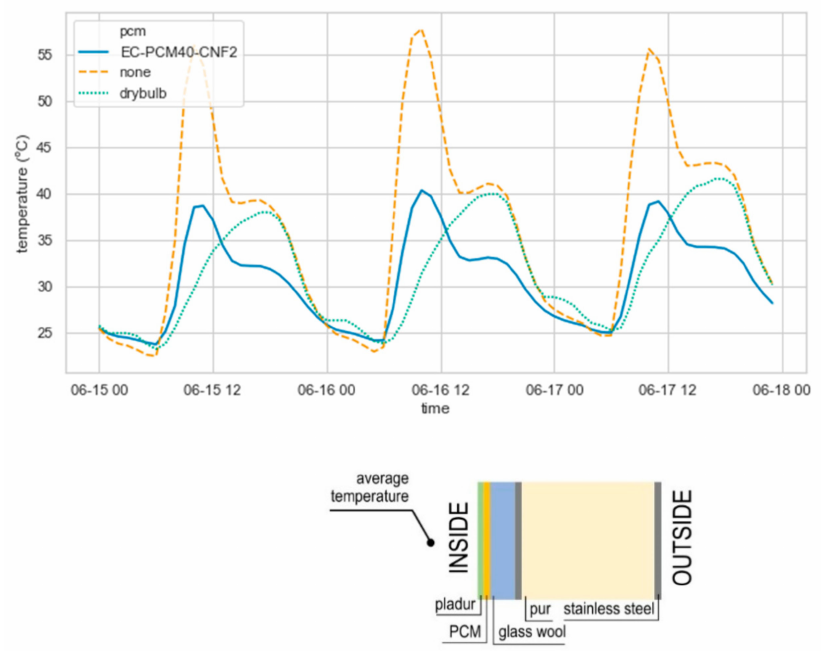
Figure 7. External wall temperature with EC-PCM40-CNF2 and without PCM (top) Outside air drybulb temperature in Yuma during 3 d (from January 15th to January 18th)